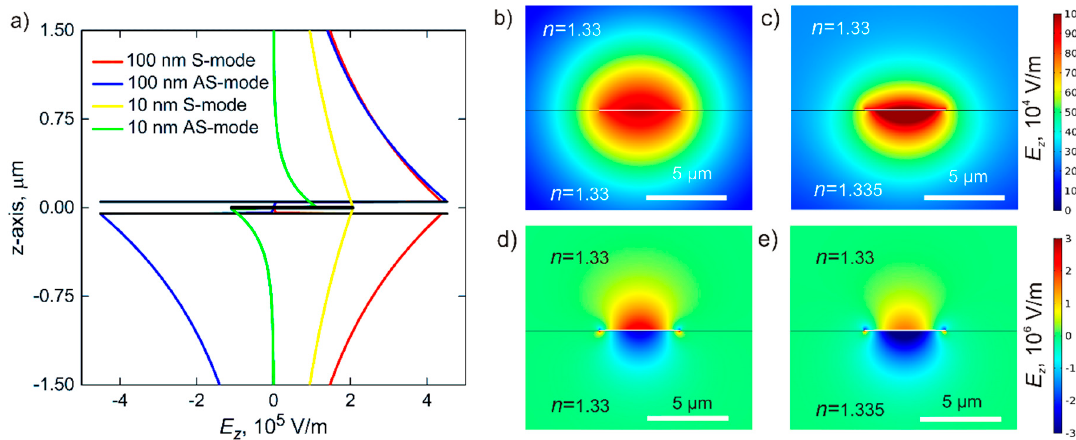
Figure 2. ( a ) Distribution of the field in plasmonic strip waveguide modes. Transverse electric field distributions for symmetric (red line) and antisymmetric (blue line) modes of a 100-nm waveguide and for antisymmetric (green line) and symmetric (yellow line) modes of a 10-nm waveguide with infinite width. Transverse electric field distributions for two eigenmodes of plasmonic strip 40-nm waveguides: ( b ) symmetric and ( d ) asymmetric mode in uniform medium, and ( c , e ) perturbation of these two modes, respectively. In the case where the waveguide lies in the boundary between mediums with different RI, Δ n = 0.005 (scale bar, 5 μ m).